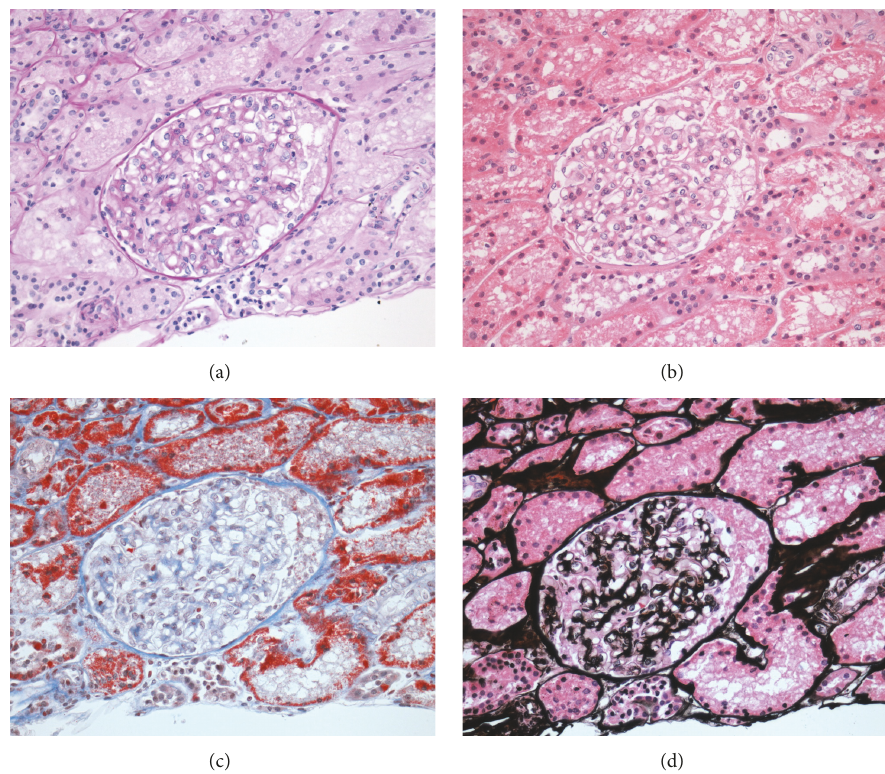
Figure 1: Zero-time biopsy of the renal graft . (a) Hematoxylin and eosin staining. (b) Periodic acid-Schiff staining. (c) Masson stain. (d) Silver methenamine stain. Renal tissue is visualized without significant vascular, tubular, and glomerular alterations. All photomicrographs are in